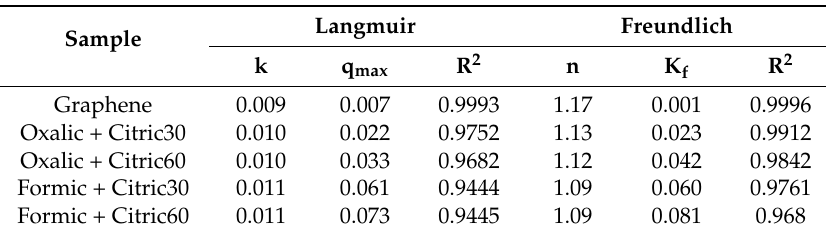
Table 4. Parameters of isotherm for uric acid adsorption, according with the Langmuir and Freundlich